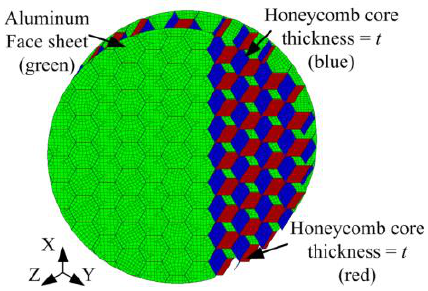
Figure 6. The mesh used to simulate a honeycomb sandwich structure.